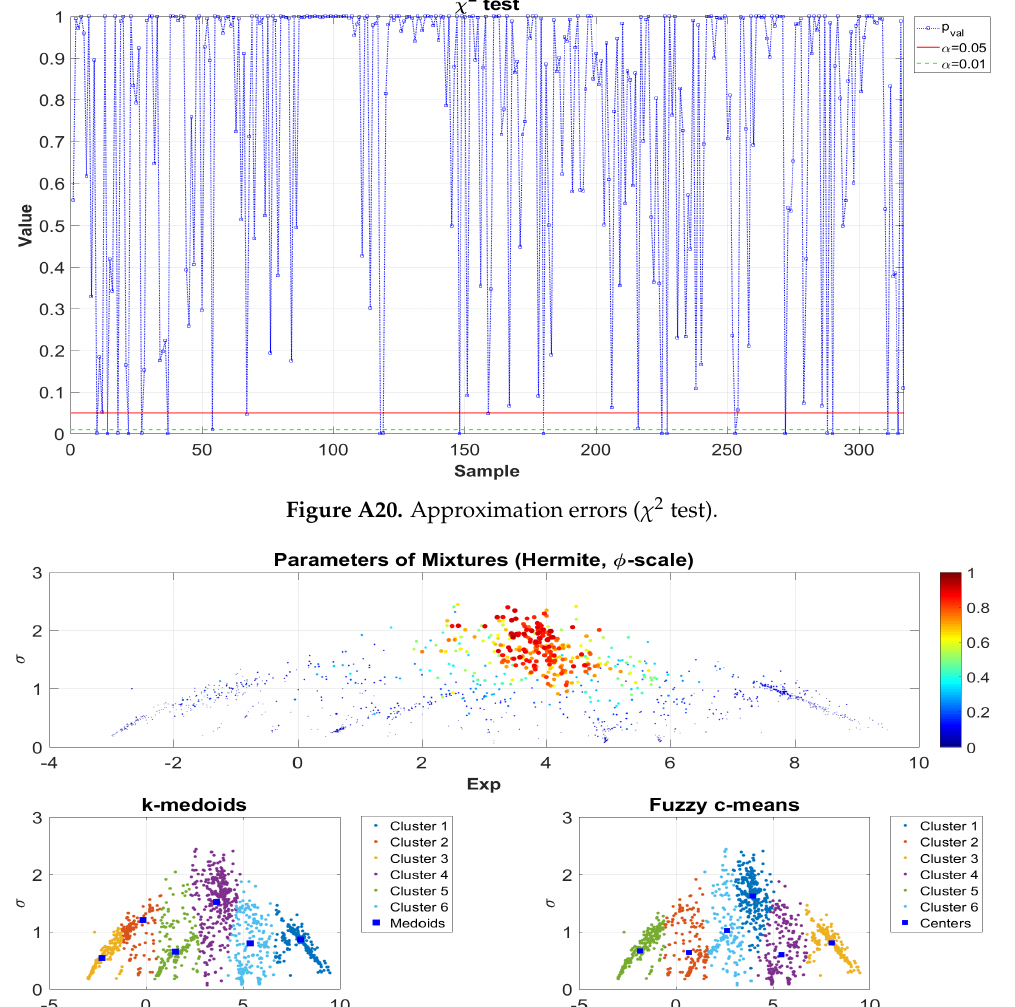
Figure A19. Soil 75081,36 (“Apollo 17”).